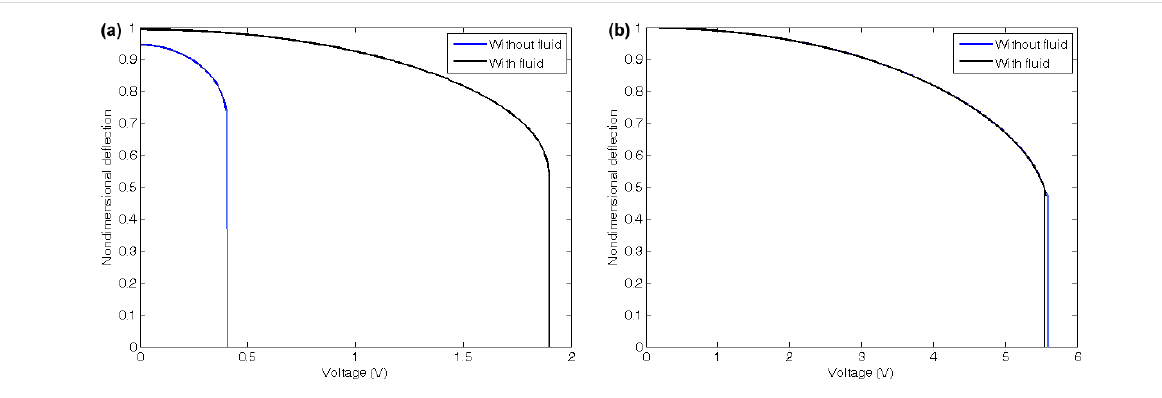
Figure 4: Effects of fluid flow on static pull-in of the (a) cantilever and (b) doubly clamped CNT under static DC voltage.